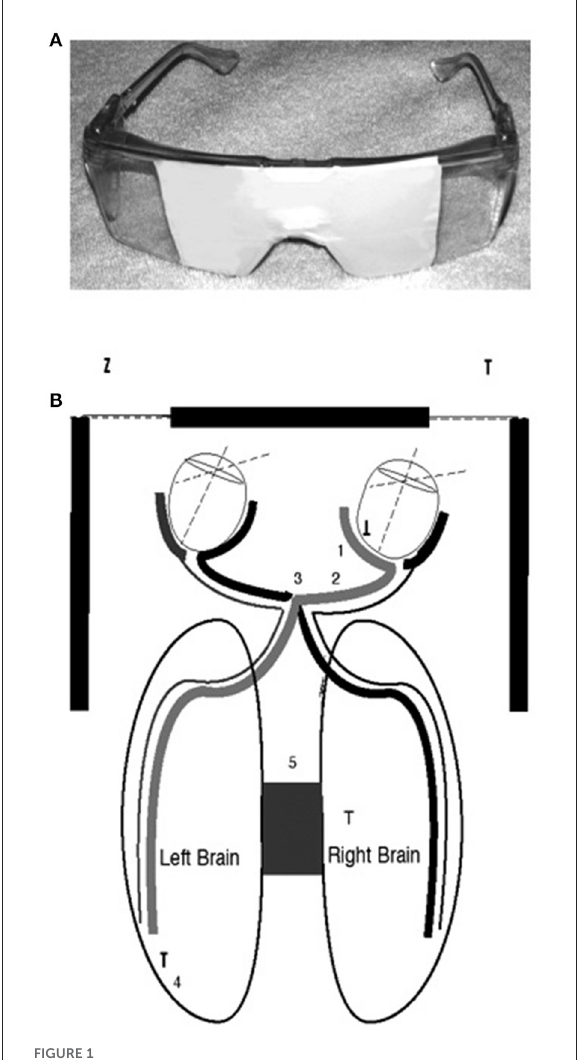
FIGURE1 (A) The top image is of taped safety goggles for lateral visual field stimulation in which looking to the right occludes the left eye and the middle of the right, and looking to the left does the opposite. A letter envelope can accomplish the same effects if it is held so that it blocks one eye and the middle of the other. (B) The bottom diagram is to demonstrate the connections between the medial and lateral retinas and the two brain hemispheres (Schiffer et al.,